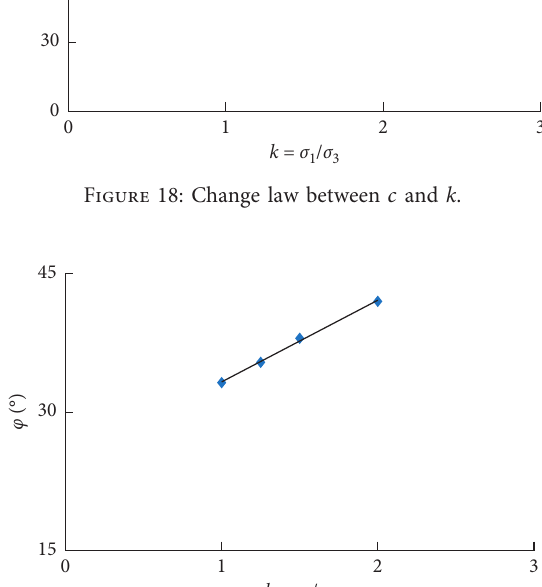
Figure 19: Change law between φ and k .